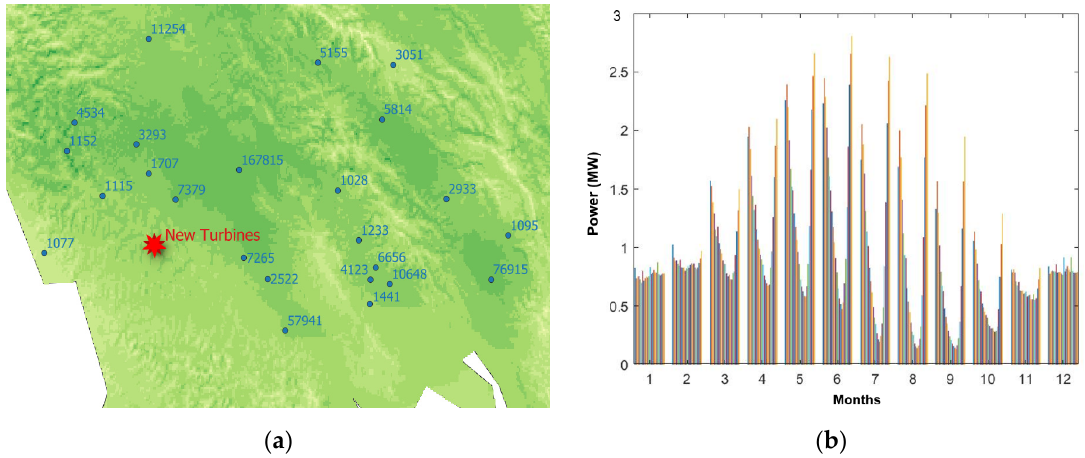
Figure 10. PSPS Cities near to the proposed new wind turbines. ( a ) Location map; ( b ) average hourly power output per month for one wind turbine.